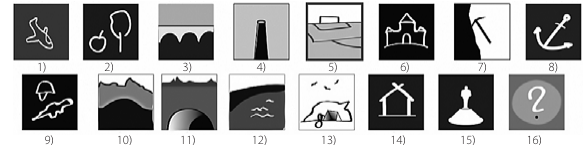
Fig. 2. Conventional symbols for the cultural type of